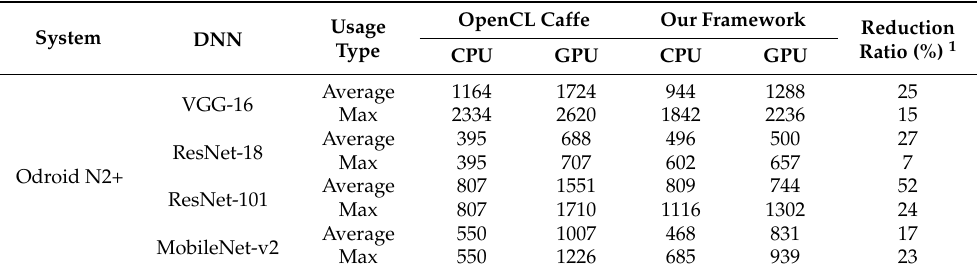
Table 9. Comparison of memory usage (MB) in Odroid